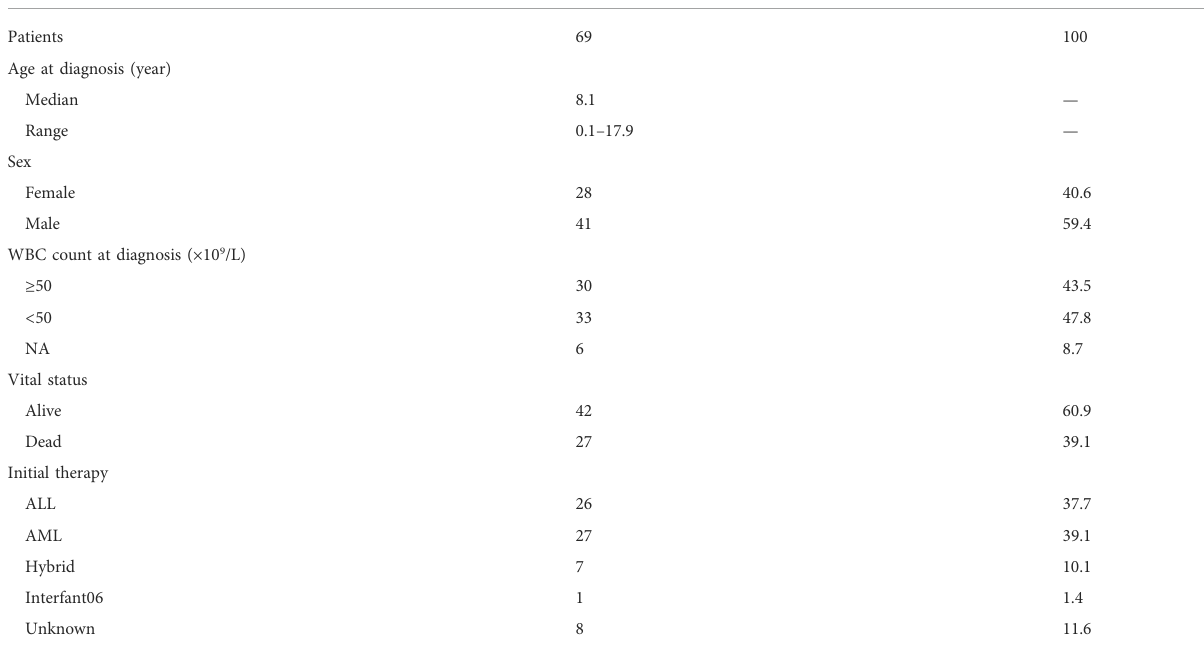
TABLE 1 Characteristic of ALL